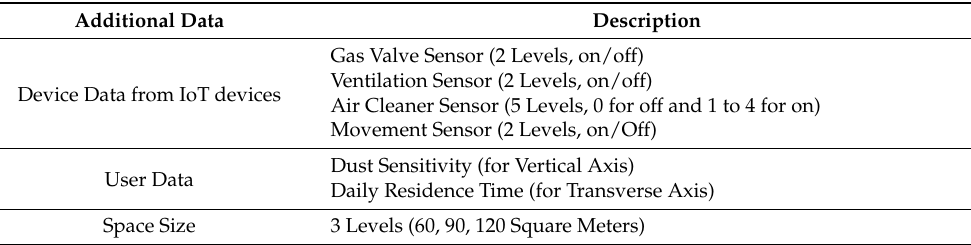
Table 4. Additional user-customized